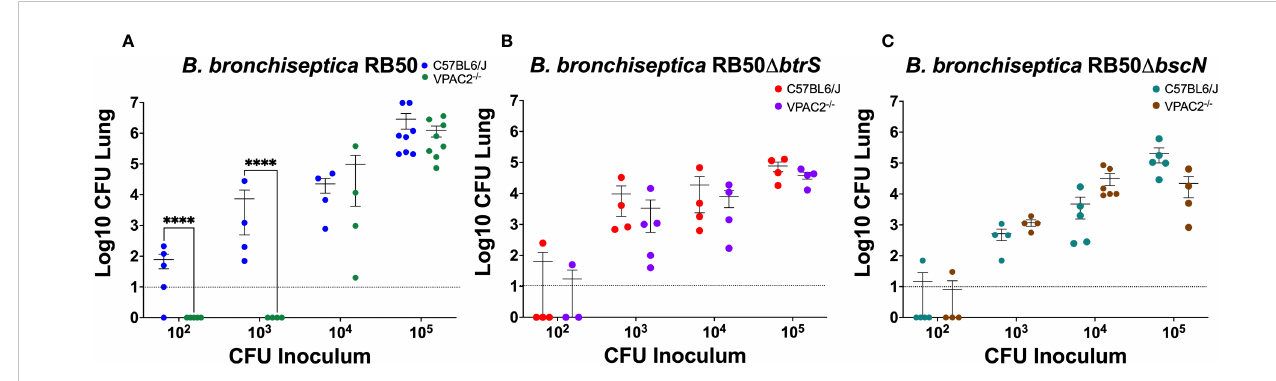
FIGURE 5 B. bronchiseptica utilize the T3SS to manipulate the host VIP/VAPC2 axis. C57BL/6J and VPAC2 -/- mice, were intranasally challenged in parallel with different concentrations of B. bronchiseptica wildtype RB50 (A) , the btrS -null mutant RB50 D btrS (B) , or the T3SS knockout mutant RB50 D bscN (C) , with each mouse strain indicated in each fi gure legend. At day 7 post-infection, we enumerated colonies from the lungs to evaluate colonization levels. Inoculations were done in parallel with independent experiment performed at least 2 times. Each point represents one mouse, with each bar representing mean ± SD (n = 4-8 mice per condition). Two-way ANOVA analysis was performed to evaluate statistical differences. ****p ≤